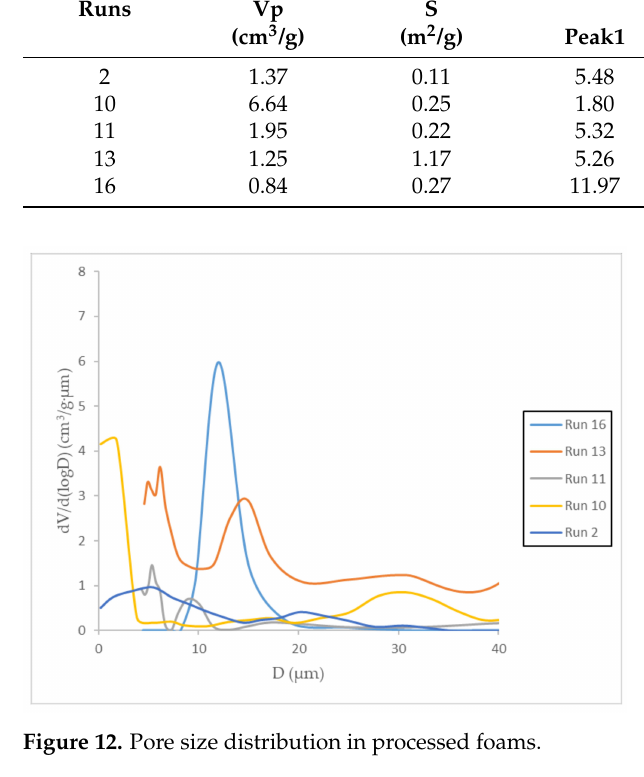
Figure 12. Pore size distribution in processed foams.